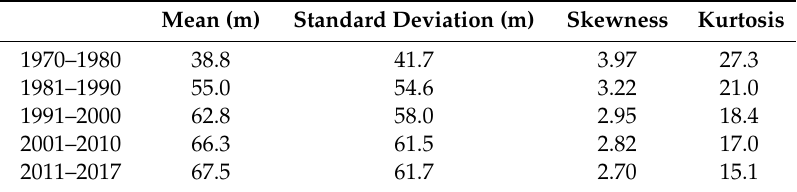
Table 2. Decadal variation of statistical characteristics of the global isothermal layer depth ( h ) in comparison to climatology.